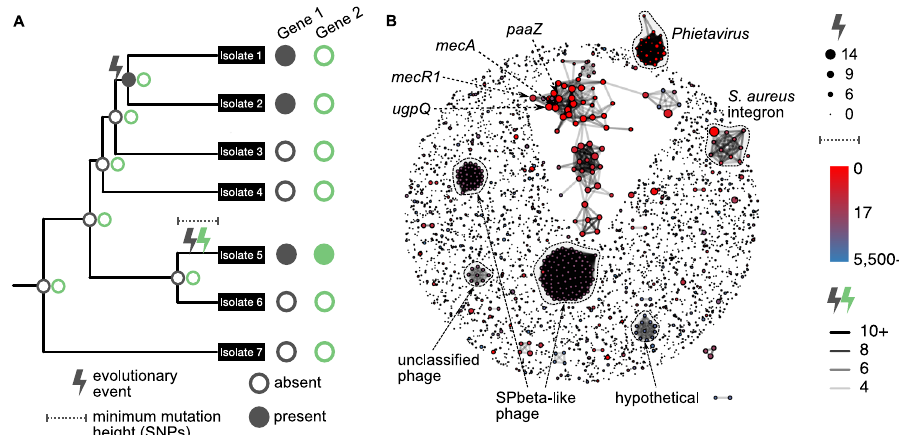
Fig. 3 A gene mediating resistance to β -lactam antibiotics ( mecA ) and neighboring genes have evolved recently and repeatedly in multiple S. epidermidis lineages colonizing multiple patients. A Schematic of inference method to determine how often and how recently gene content evolution has occurred for each gene in the pangenome of this S. epidermidis population. B Network of pangenome-wide gene gain-loss evolution. Nodes are individual open reading frames (ORFs). The size of the node indicates the number of evolutionary events undergone by that ORF, and the color of the node indicates the height of the most recent mutation (a measure for time since a gene gain or loss event). Edges link genes that evolved concurrently on at least four branches of the population-wide phylogeny. Clusters of genes are annotated by best BLAST hit. Source data are provided as a Source Data fi